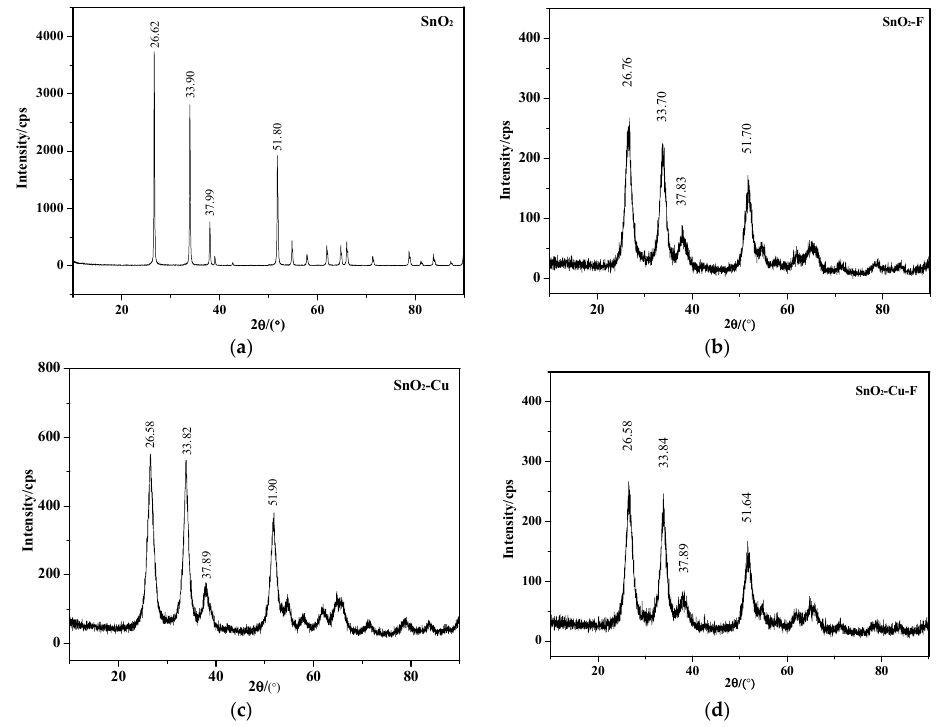
Figure 4. XRD patterns of SnO 2 powder before and after doping. ( a ) SnO 2 ; ( b ) SnO 2 -F; ( c ) SnO 2 -Cu; ( d ) SnO 2 -Cu-F. ( d ) SnO 2